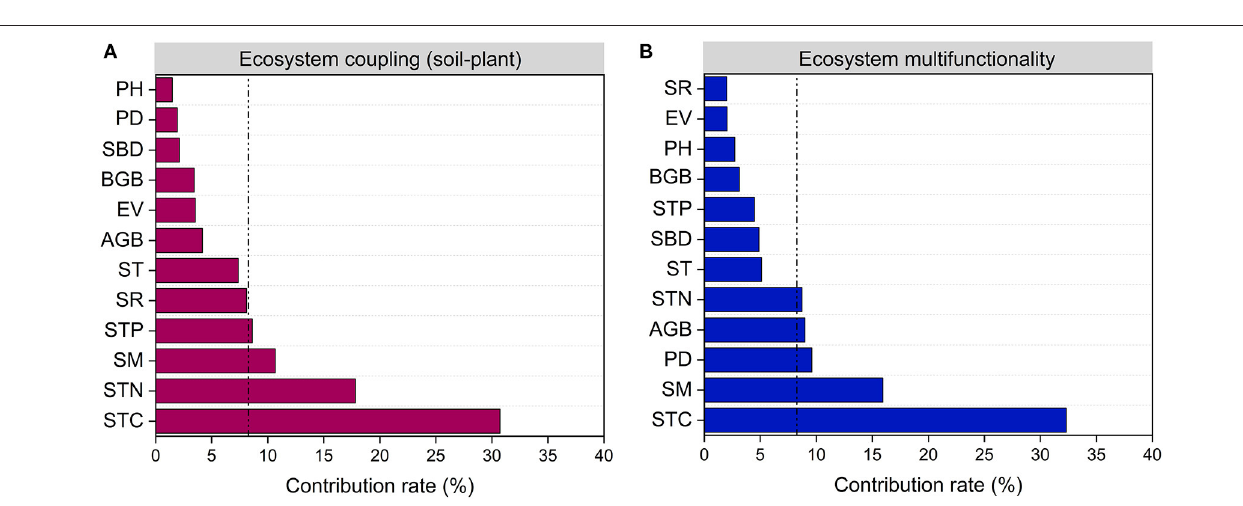
FIGURE 6 | Relative importance of environmental and biological factors explaining ecosystem coupling (A) and ecosystem multifunctionality (B) . AGB, aboveground biomass; SR, plant species richness; EV, Camargo evenness index; BGB, belowground biomass; PD, plant density; PH, plant height; SBD, soil bulk density; SM, soil moisture; ST, soil temperature; STC, soil total carbon; STN, soil total nitrogen; STP, soil total